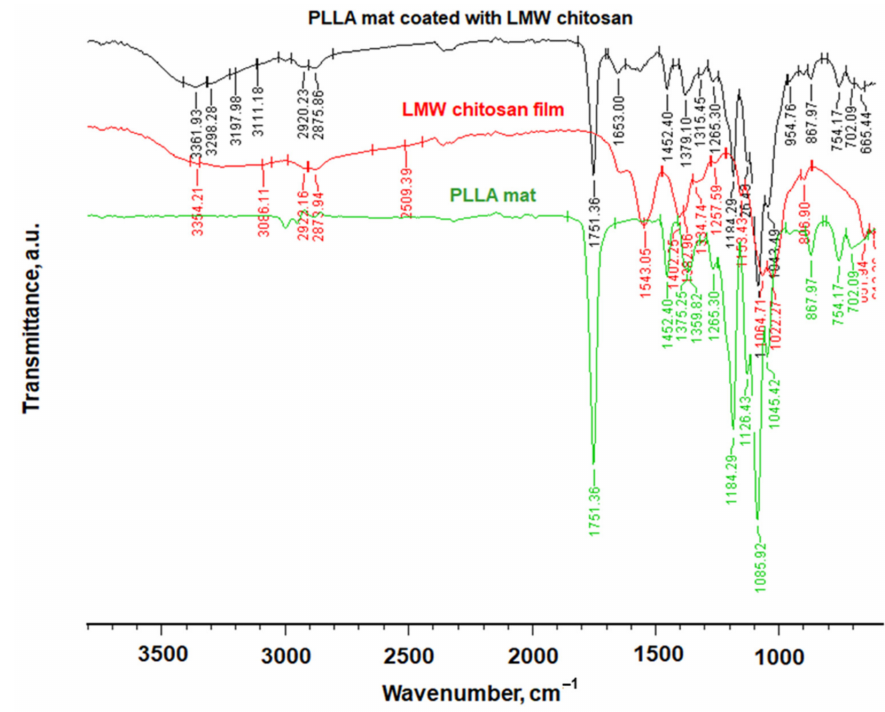
Figure 3. FTIR spectra of PLLA mat, LMW chitosan film and PLLA mat coated with LMW chitosan.